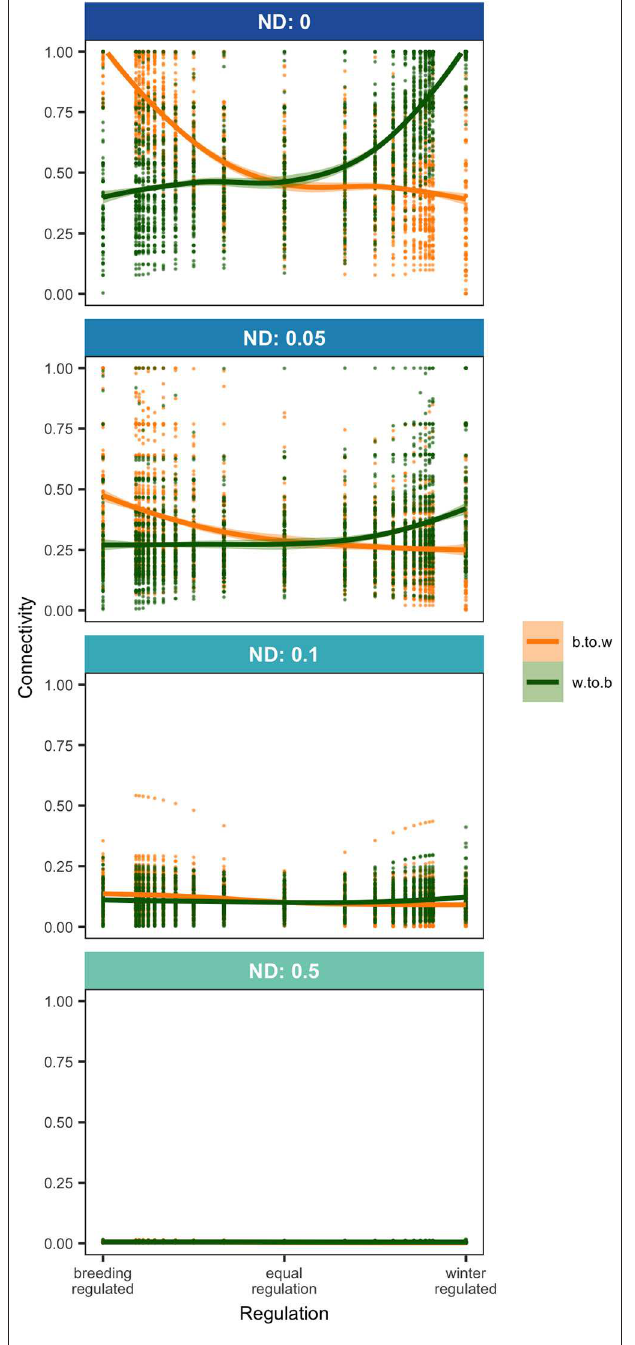
FIGURE 2 | Breeding-to-winter (b.to.w; NMC BW ) and winter-to-breeding (w.to.b; NMC WB ; Equation 1) connectivity in networks where regulation (Equation 7) varies from 0 to 1 at four levels of natal dispersal, ND . Points show the results of model runs and trendlines are fitted locally weighted polynomial (loess) curves.